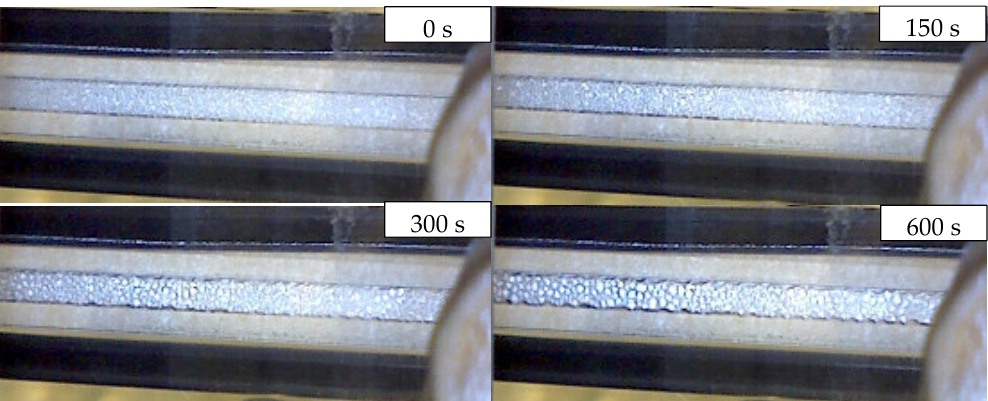
Figure 9. Degree of condensation of the evaporated and diffusively transported liquid species at 40 °C within the sweep gas channel on the supporting material, observed for different operating times. Illustrated pictures are for following operating times 0 s, 150 s, 300 s, and 600 s using V l,feed,in = 5 mL/min, V g,feed,in = 0 NmL/min, and V g,sweep,in = 0